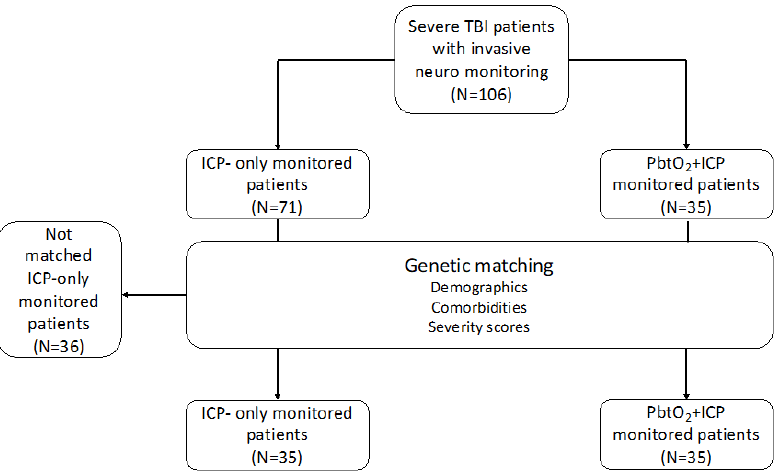
Figure 1. Flowchart of the genetic matching. TBI: traumatic brain injury; ICP: intracranial pressure; PbtO 2 : brain tissue oxygenation; ICU: intensive care unit.